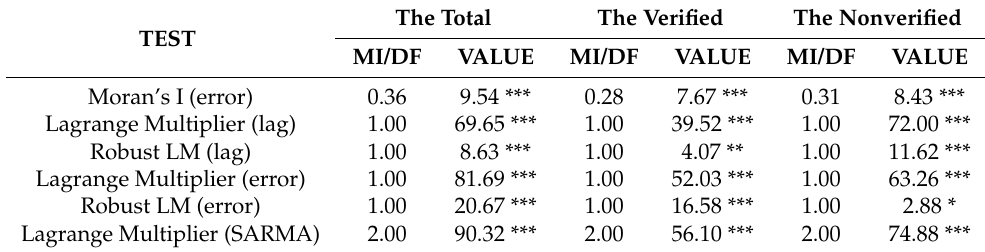
Table 3. Diagnostics for spatial